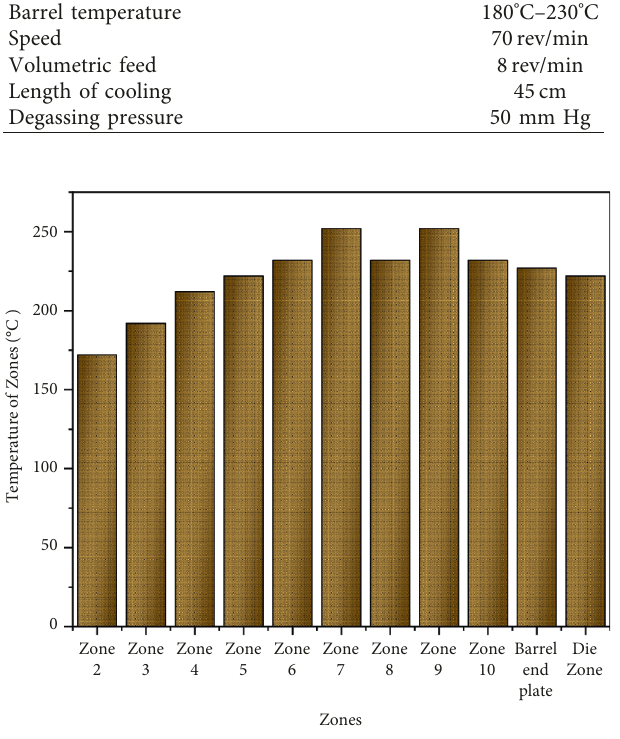
Figure 1: Different temperature zones of